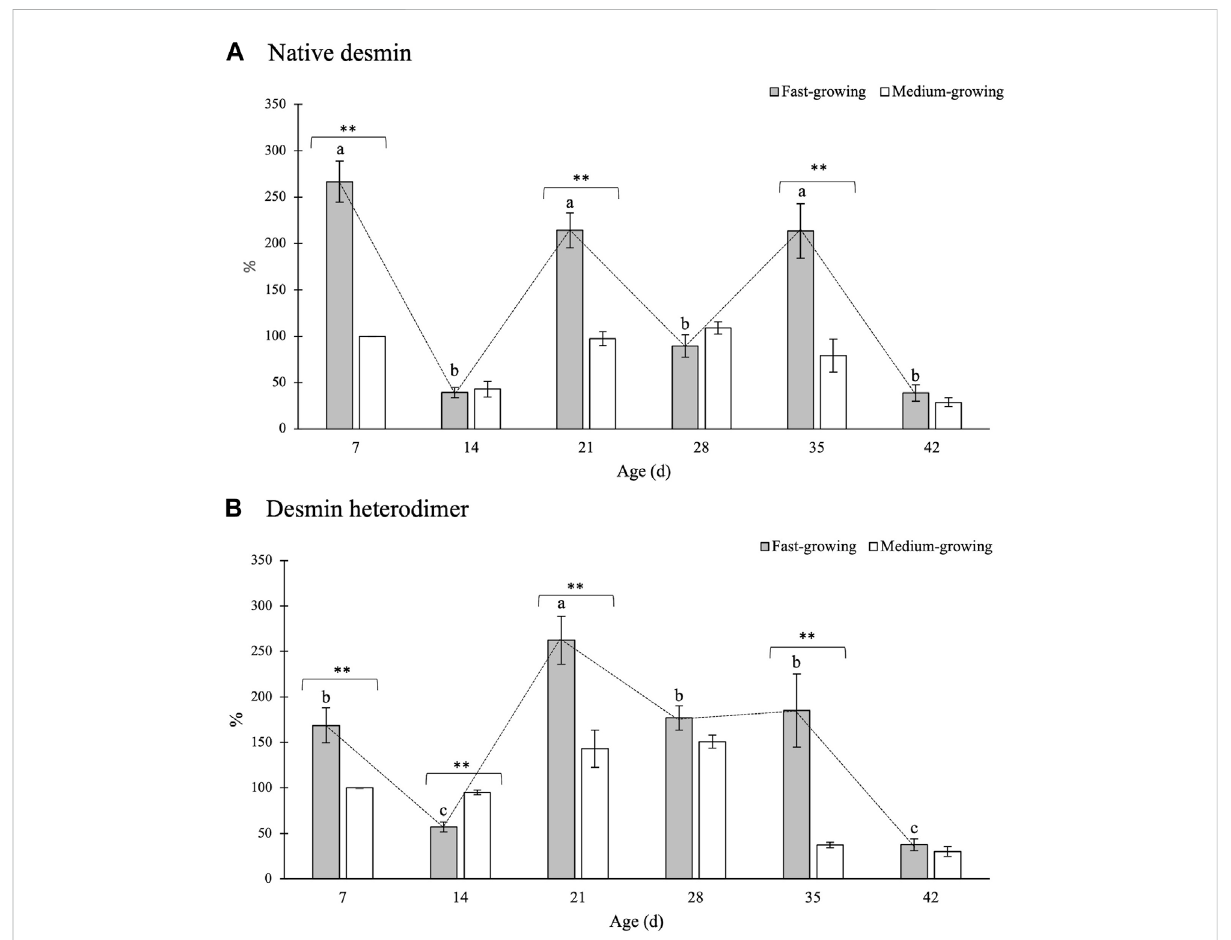
FIGURE 5 Relative concentrations of native desmin (A) and of its heterodimeric form (B) in Pectoralis major muscles of broiler chickens belonging to a fast- and medium-growing genotype at different ages. The results are expressed as %, considering as 100% the intensity of the band in MG at the beginning of the rearing period (day 7 – d 7). Error bars indicate standard error of mean. Within the same age (7, 14, 21, 28, 35, and 42 days) data were analyzed by using the non-parametric Mann-Whitney U test to investigate the effect of the genotype (FG vs. MG). * and ** = within the same age, mean values signi fi cantly differ between FG and MG for a p -value < 0.05 and < 0.01, respectively. On the other hand, the evolution of desmin in FG over their growth period was assessed by One-way ANOVA. a-c = for FG, mean values followed by different letters signi fi cantly differ over the growth period ( p <